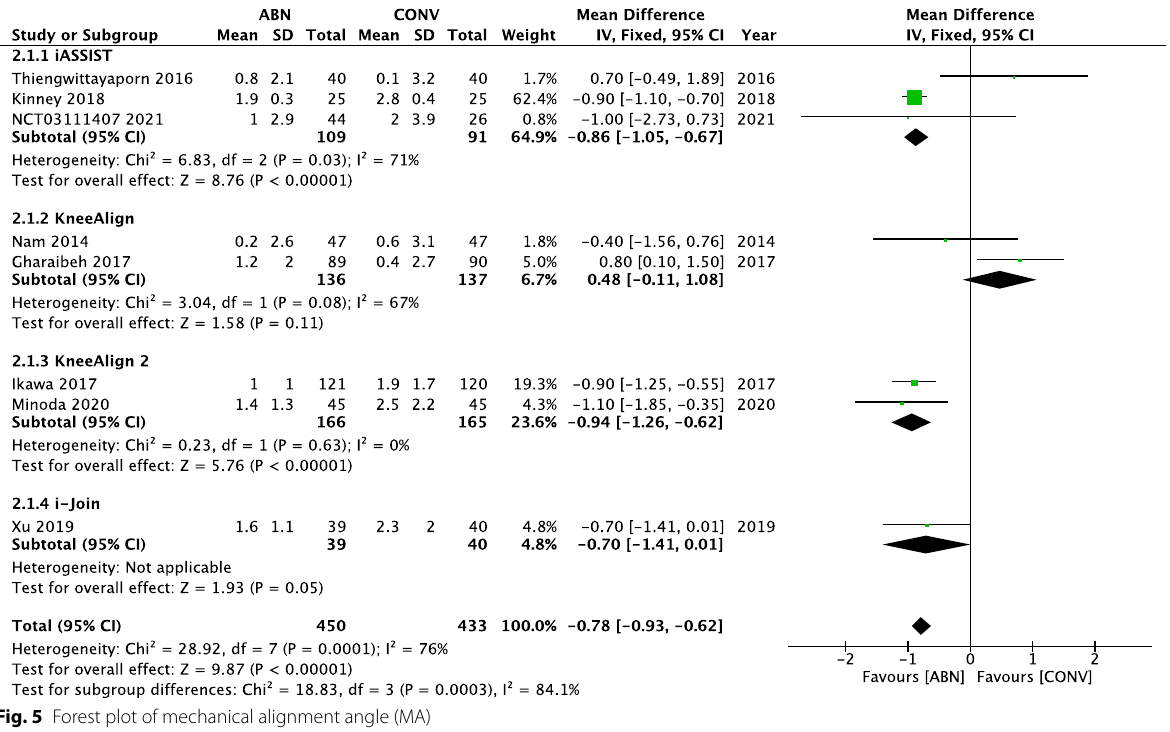
Fig. 5 Forest plot of mechanical alignment angle